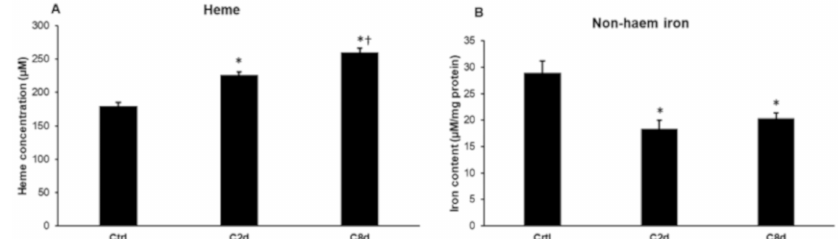
Figure 7. Heme concentrations and non-heme iron contents of the liver in non-treated and CZ-treated animals. Heme contents were determined using Heme Assay Kit according to the manufacturer’s protocol and were expressed in µ M. Non-heme iron contents were determined using a colorimetric ferrozine-based assay. The values were expressed as µ M iron / mg protein. ( A ) Heme concentrations of the liver samples of the CZ-treated animals. ( B ) Non-heme iron contents of the liver samples of the three animal groups. The columns represent mean values and error bars represent standard errors of the mean (SEM) for three independent measurements. For statistical analyses, a two-sample t -test was used. The asterisk marks p < 0.05 compared to non-treated animals, while the cross indicates a di ff erence p < 0.05 between the treated groups, n = 6 in each